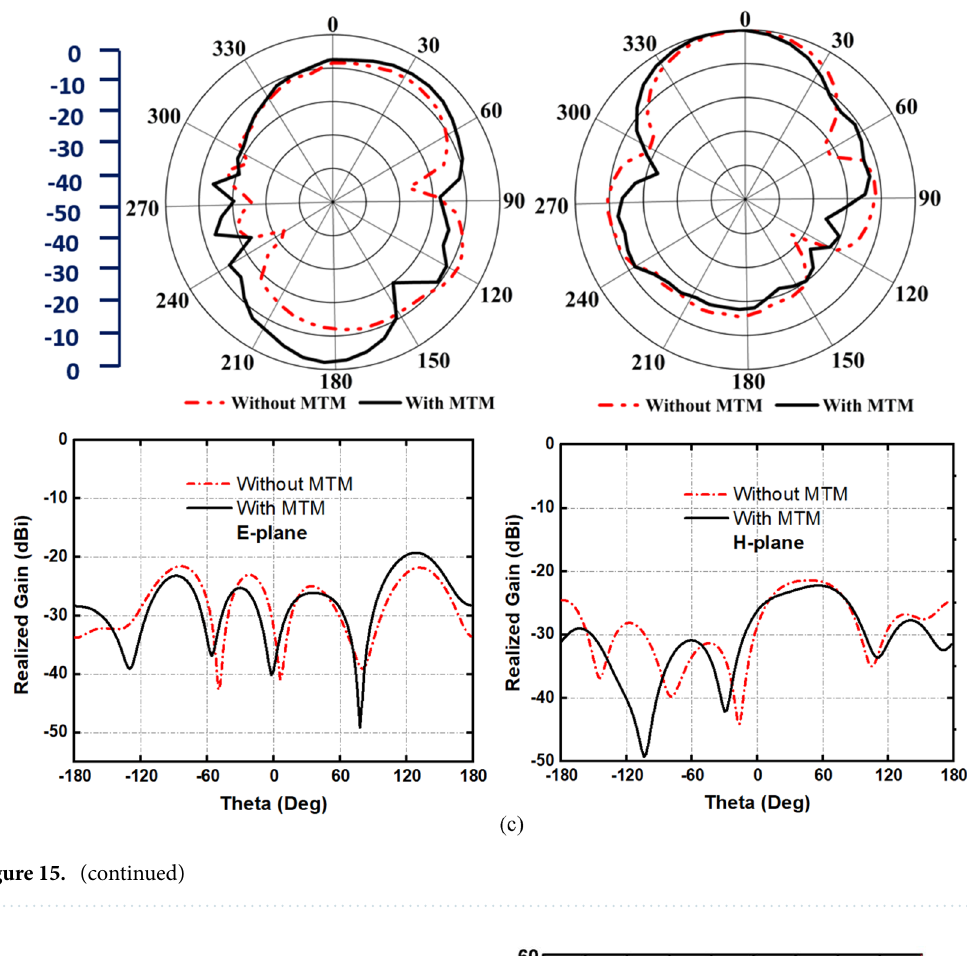
Figure 16. Near-field head model analysis ( a ) with MTM ( b ) without MTM and ( c ) radiation efficiency and realized gain.